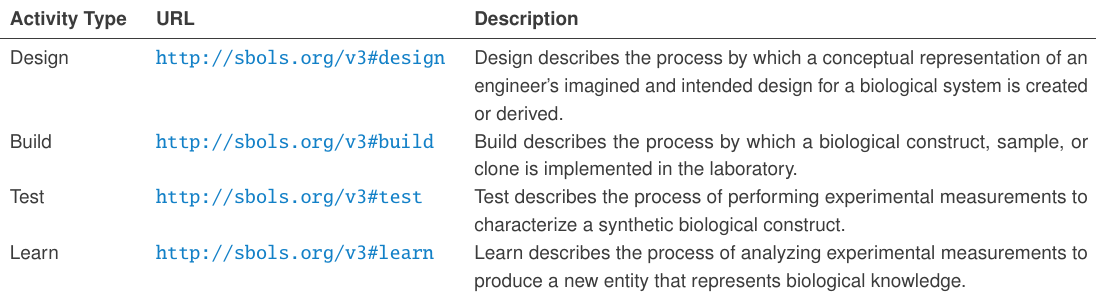
Table 20: Synthetic biology workflow ontology